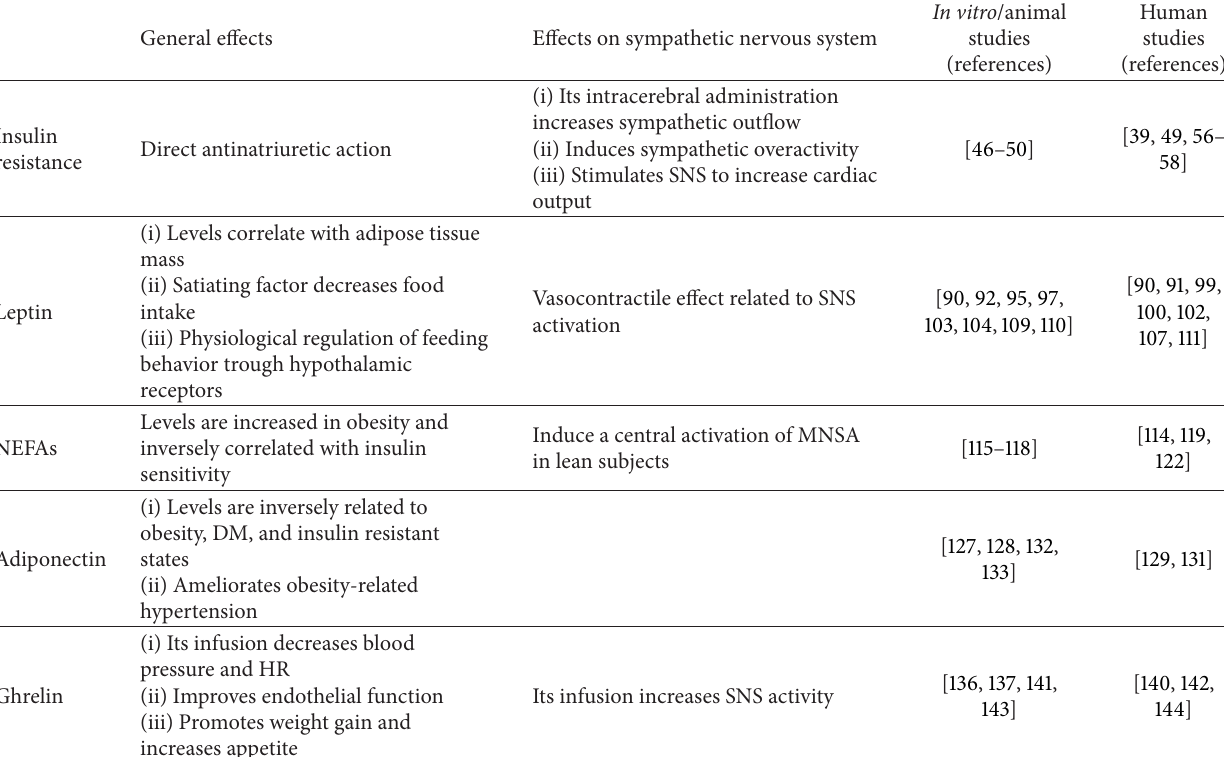
Table 1: Effects of insulin resistance, ghrelin, and some adipokines on endocrine and metabolic functions in the pathogenesis of the